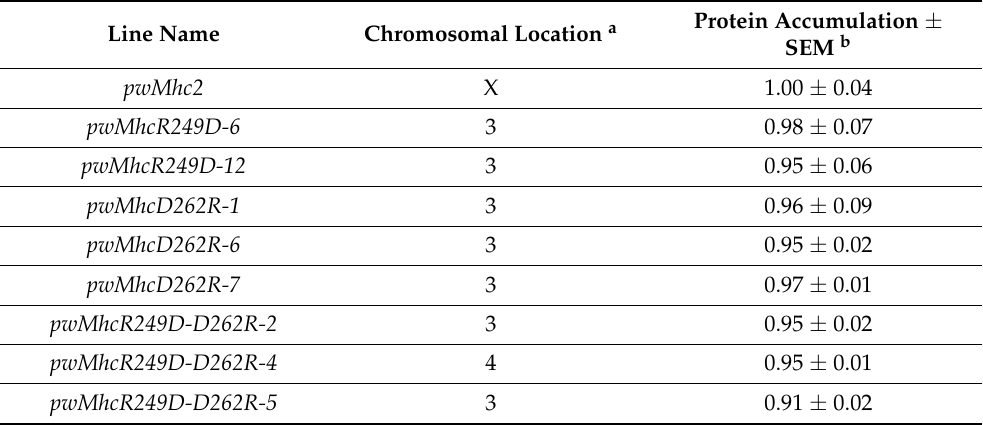
Table 1. Transgenic lines, locations and myosin expression